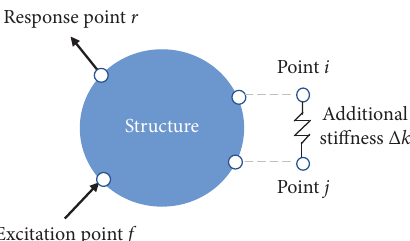
Figure 1: Measurement points and additional stifness on the